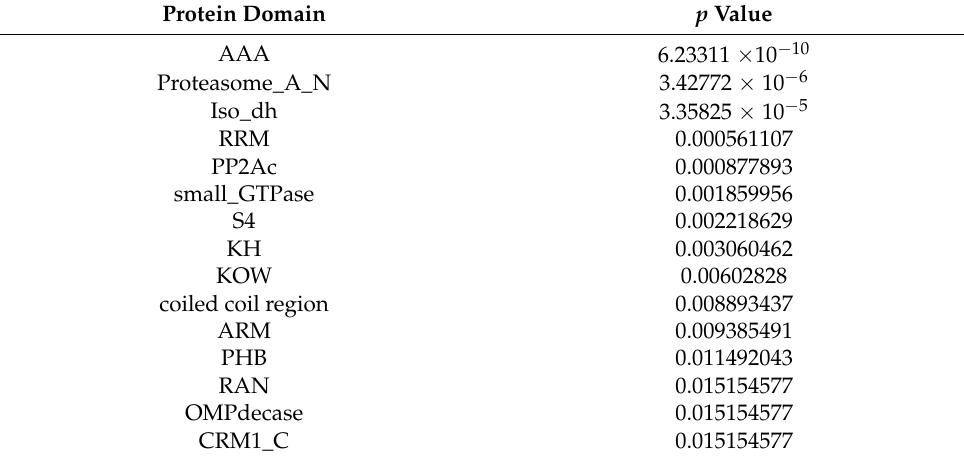
Table 2. Enriched protein domains of ASFV MGF360-9L-PK-15 cell-interacting proteins. Protein